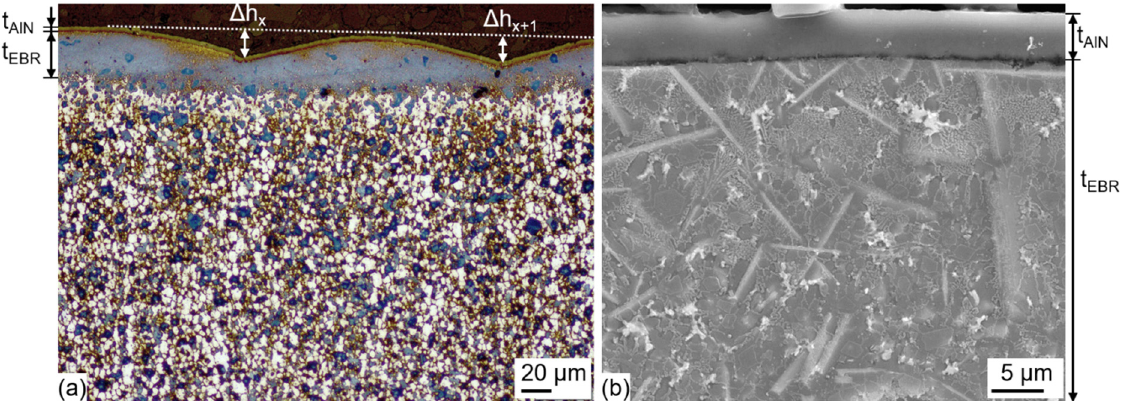
Figure 3. Influence of EBR (line scan; vx = 12 mm/s; I B = 10 mA) on ( a ) the surface topography in the light optical cross section ( Δ h x … height difference), and ( b ) the microstructure (SEM-SE contrast).